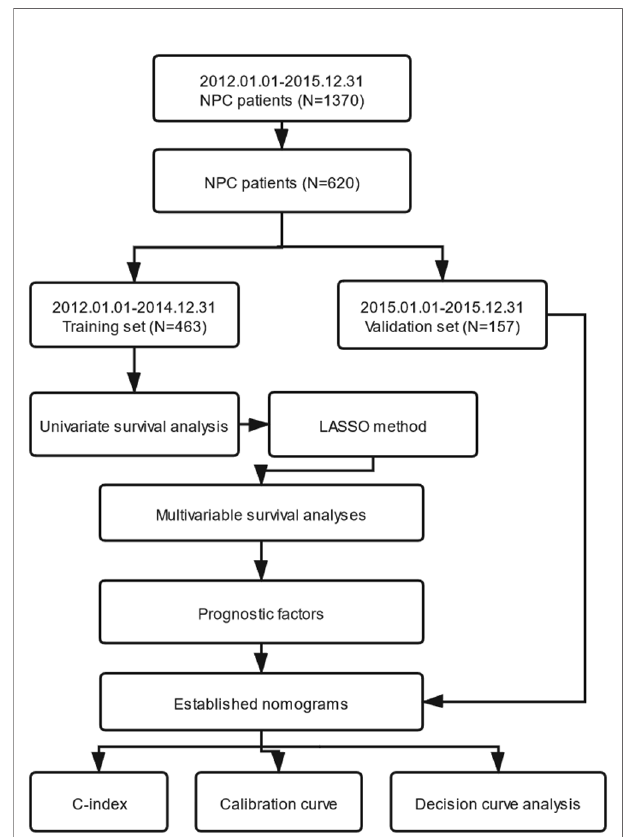
FIGURE 1 | The entire analysis procedure. NPC, nasopharyngeal carcinoma; LASSO, least absolute shrinkage and selection operator; C-index, concordance